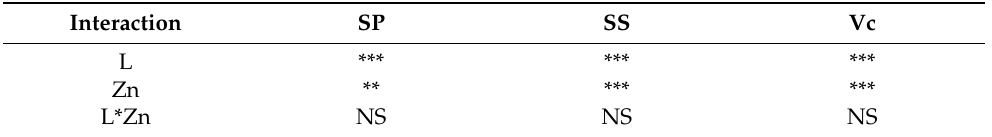
Table 4. The interaction effects of SP (soluble protein), SS (soluble sugar) and Vc (vitamin C) in flowering Chinese cabbage sprouts (FCCS).